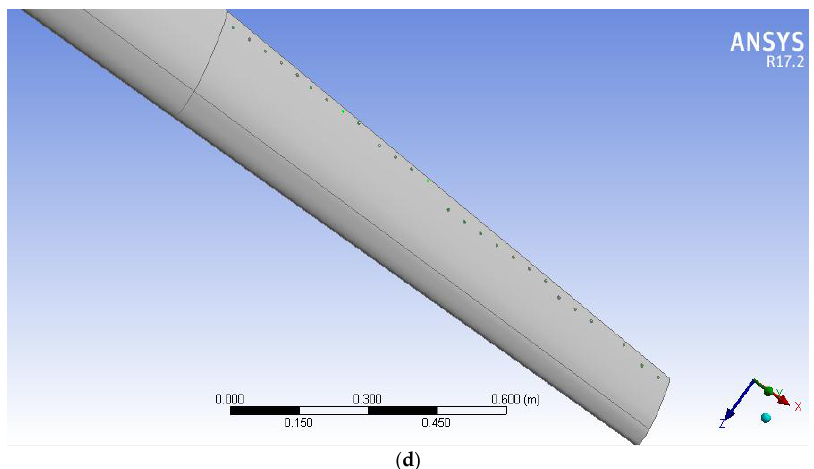
Figure 3. Different array arrangements of the surface bumps. ( a ) Scenario 1 ( b ) Scenario 2 ( c ) Scenario 3 ( d ) Scenario 4.